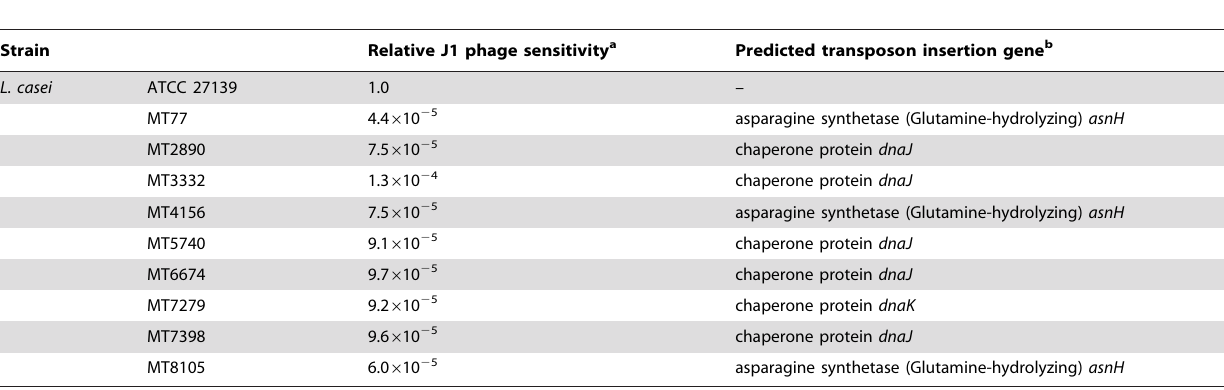
Table 1. Summary of relative sensitivities to J1 phage infection and predicted transposon insertion loci of J1 phage-resistant